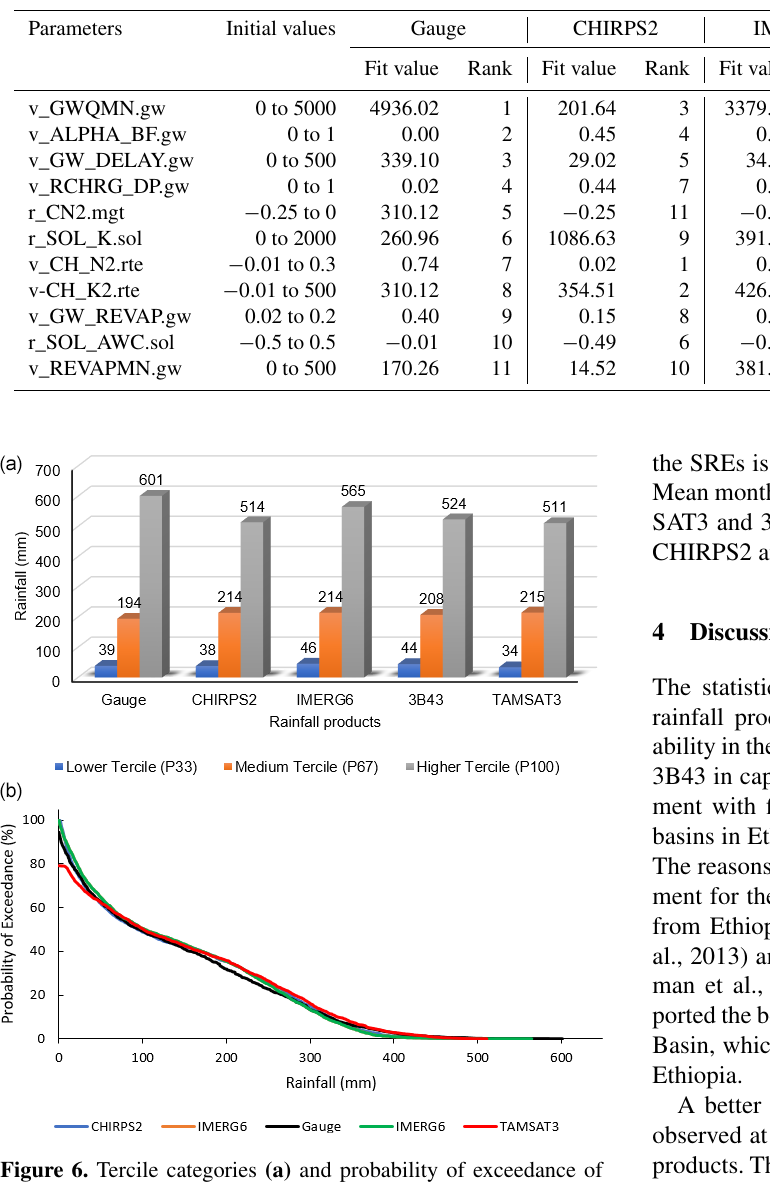
Table 4. Initial parameter ranges, fit values and sensitivity ranks for rainfall data sources.